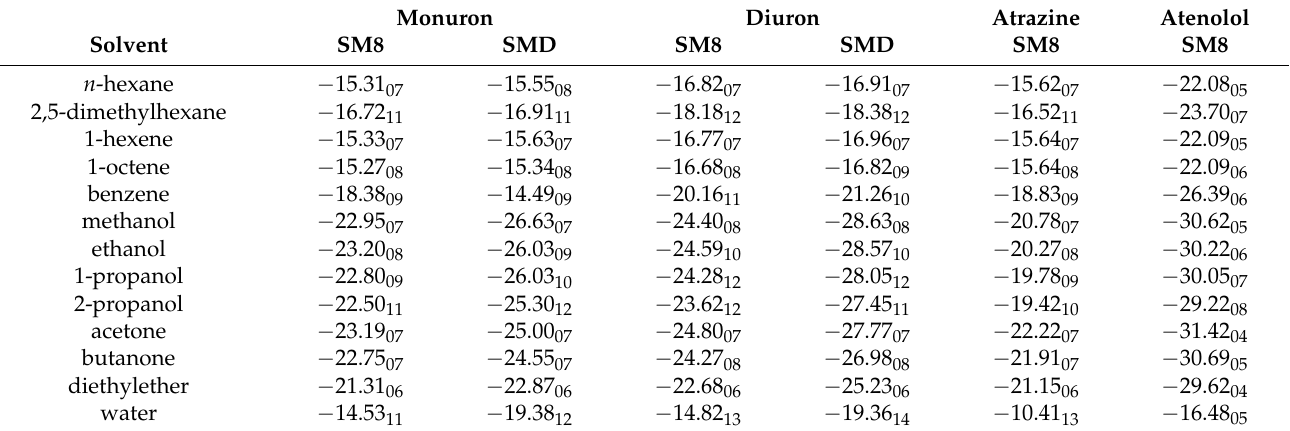
/ ( RT ) , for solute i in solvent j i , j